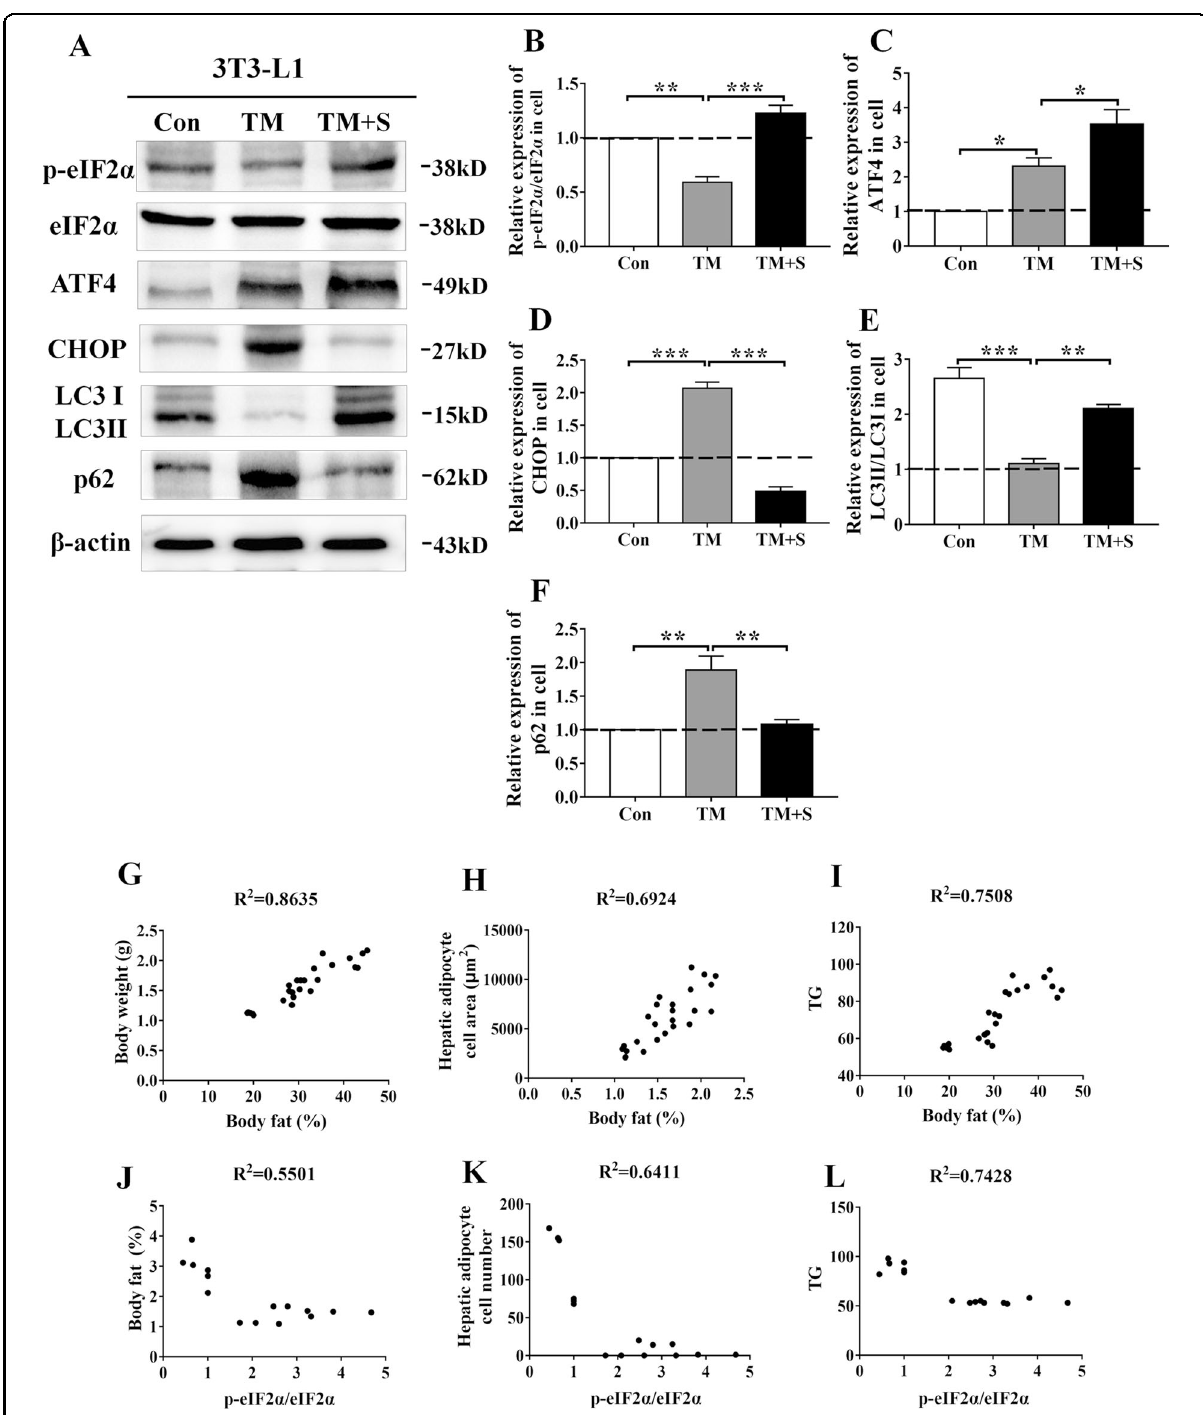
Fig. 7 Maintaining eIF2 α phosphorylation altered the ER stress and autophagy in 3T3-L1 cells. a Representative images of Western blot for selected genes involved in ER stress (p-eIF2 α , ATF4, and CHOP) and autophagy (LC3 and p62). b – f Relative intensity of p-eIF2 α /eIF2 α ( b ), ATF4 ( c ), CHOP ( d ), LC3II/I ( e ), p62 ( f ). The experiments were conducted in triplicate. The asterisks (*, **, and ***) represent P < 0.05, P < 0.01, and P < 0.001, respectively (S: salubrinal and TM: tunicamycin). g – i The expression level of body fat was positively associated with body weight ( g ), hepatic adipose cell area ( h ), and serum triglyceride ( i ). j – l The expression level of p-eIF2 α /eIF2 α was negatively associated with body fat ( j ), hepatic adipose cell area ( k ), and serum triglyceride ( l